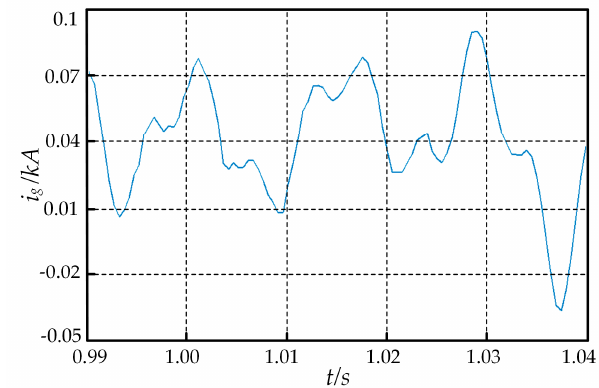
Figure 18. i g during DC pole-to-pole fault.